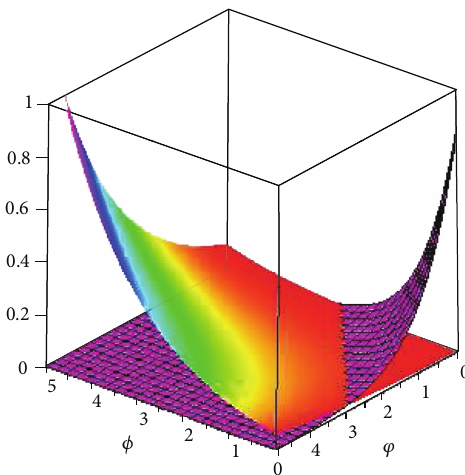
Figure 1: The behavior of the runaway potential (chromatic surface) and the coupling term 𝑒 𝜅𝛽(𝜙+𝜑) (the magenta meshed surface) with respect to the two components ( 𝜙 and 𝜑 ) of the hybrid scalar field. By increment of the scalar fields, the runaway potential decreases, while the coupling term